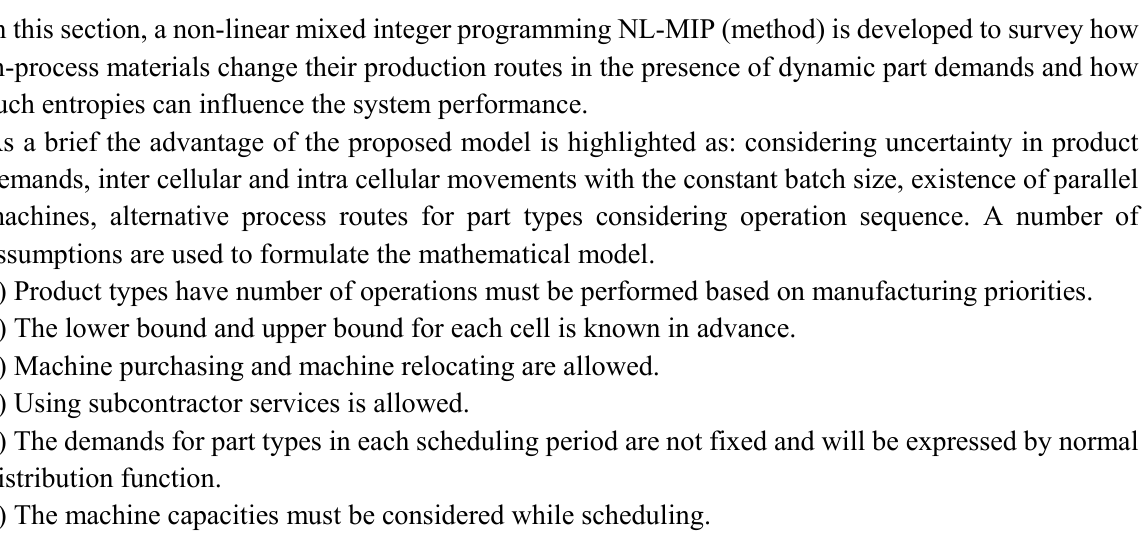
Fig. 1. Flowchart for finding the best trade off values between in-house manufacturing, outsourcing and backorder while machine purchasing is